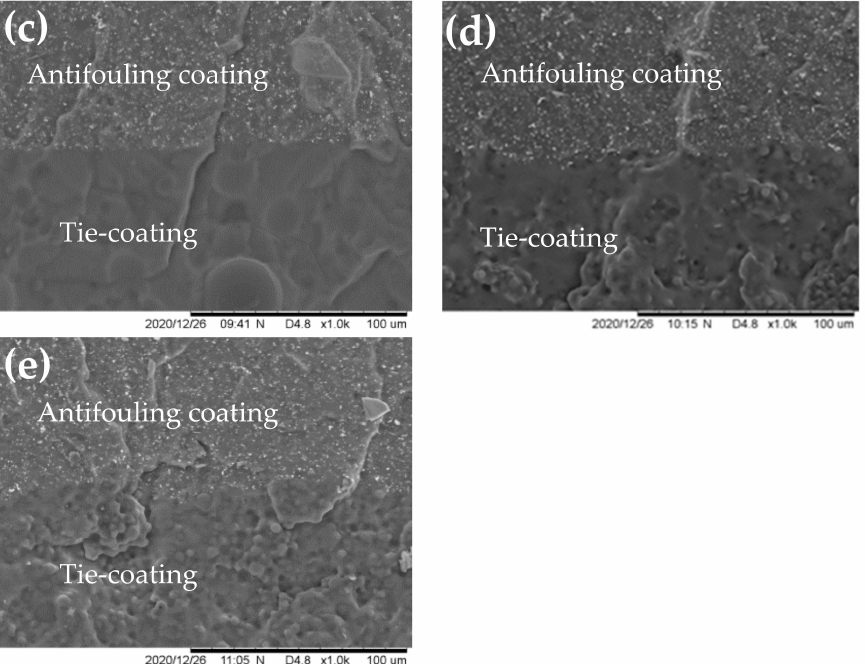
Figure 10. SEM images of fracture (Antifouling coating /Tie-coating). ( a ) ES-9, ( b ) ES-18, ( c ) ES-26, ( d ) ES-34, ( e )